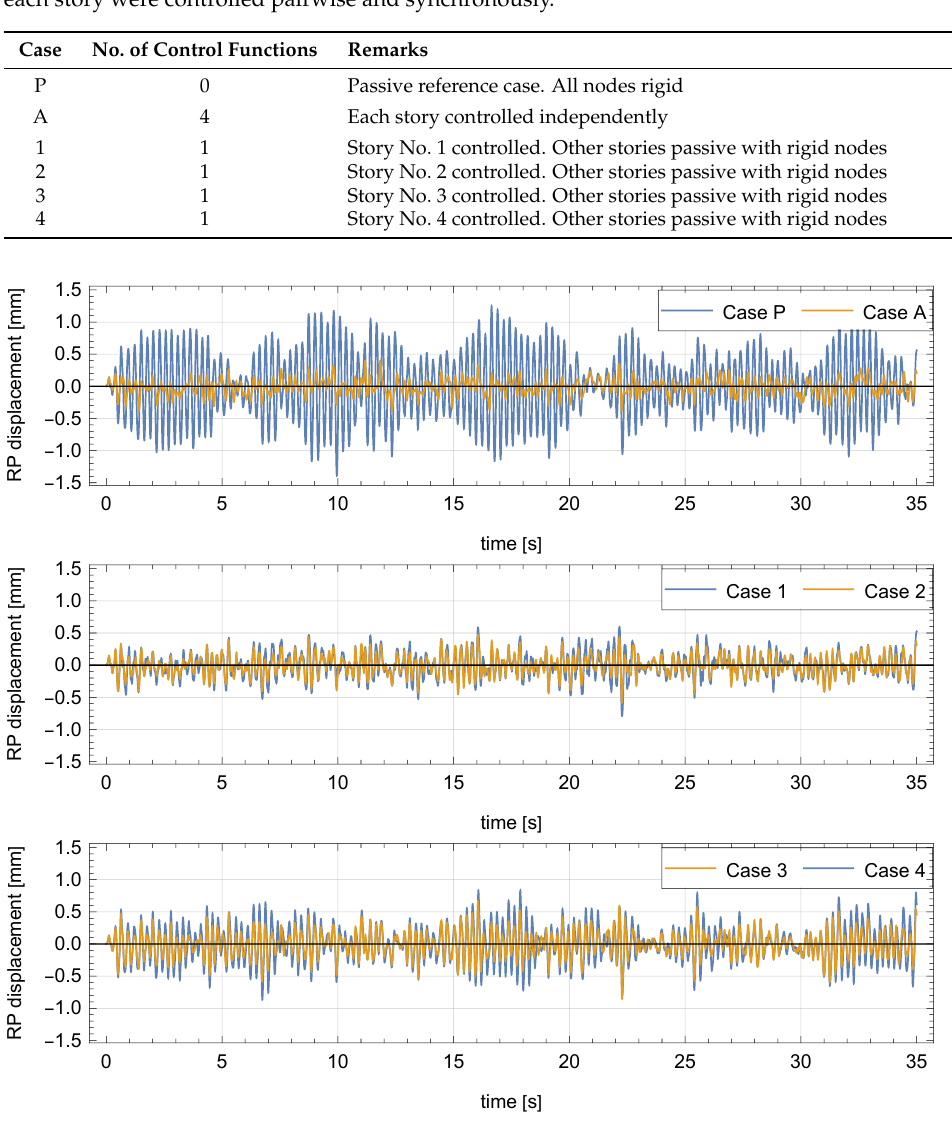
Figure 3. Example displacements of the reference point for the passive and fully controlled structures (Case P and Case A, top plot); the first- and second-story-controlled structures (Case 1 and Case 2, middle plot); and the third- and fourth-story-controlled structures (Case 3 and Case 4, bottom plot). All plots used vertical axes of the same